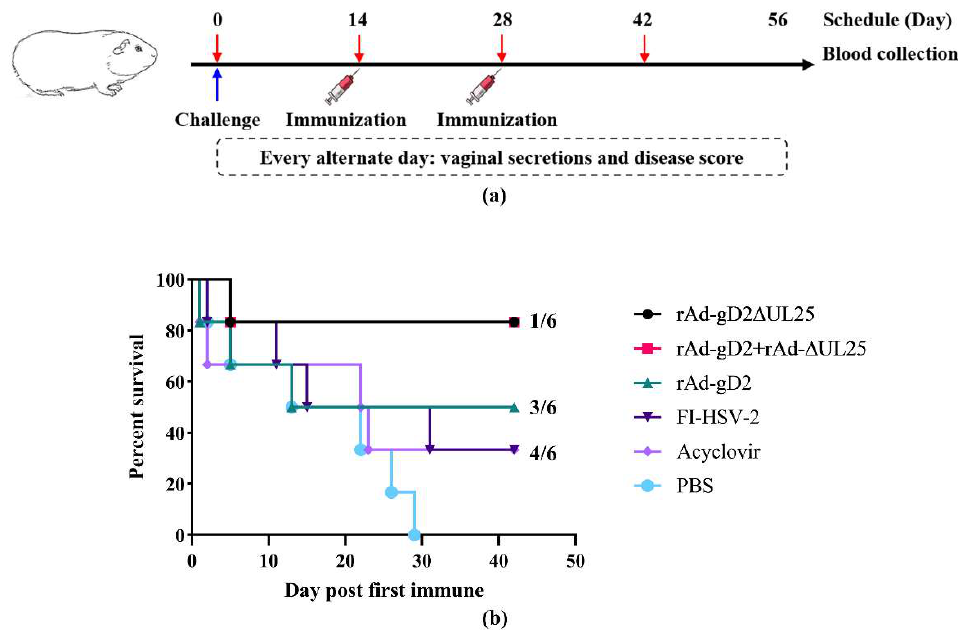
Figure 2. Experimental scheme and percent survival of guinea pigs in 42 days ( a ) Experimental scheme. Guinea pigs were challenged at day 0 and immunized with recombinant adenovirus vaccines, FI-HSV-2, or PBS twice at 1- and 28 dpi. Sera samples were collected at 0, 14, 28, and 42 dpi, and vaginal secretions were collected every alternate day from 0 to 56 dpi. ( b ) The X -axis shows days post-immunization, and Y -axis shows the percentage of surviving guinea pigs ( n = 6 per group). The number to the right is the number of dead animals/total number of animals in each group. Both rAd-gD2 ∆ UL25 and rAd-gD2 + rAd- ∆ UL25 had a survival percentage of 83.3%, rAd-gD2 had 50%, FI-HSV2 and acyclovir had 33.33%, and PBS had